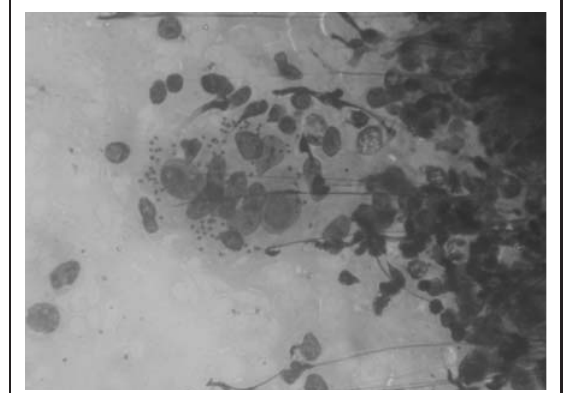
Figure 2. FNAC smear, Giemsa stain, 40x; an epithe- lioid granuloma containing amastigote of Leishmania.